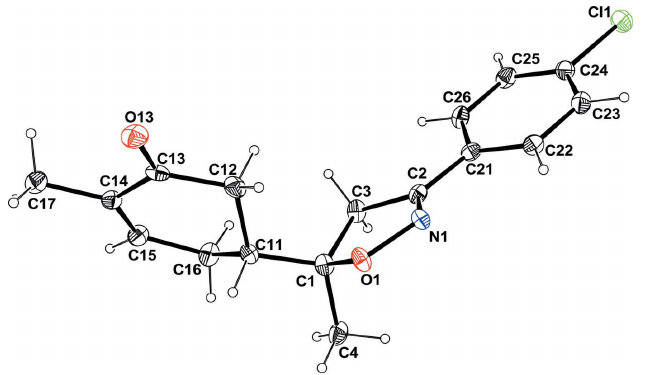
Figure 1 Molecular structure of the title compound with the atom-numbering scheme. Displacement ellipsoids are drawn at the 50% probability level. H atoms are represented as small circles of arbitrary